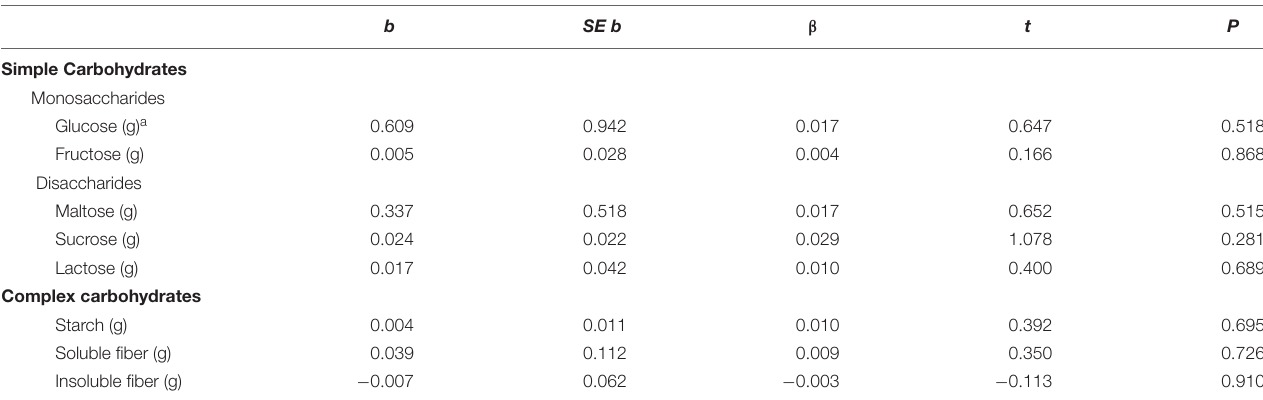
TABLE 3 | Linear regressions between each type of carbohydrate and recollection accuracy